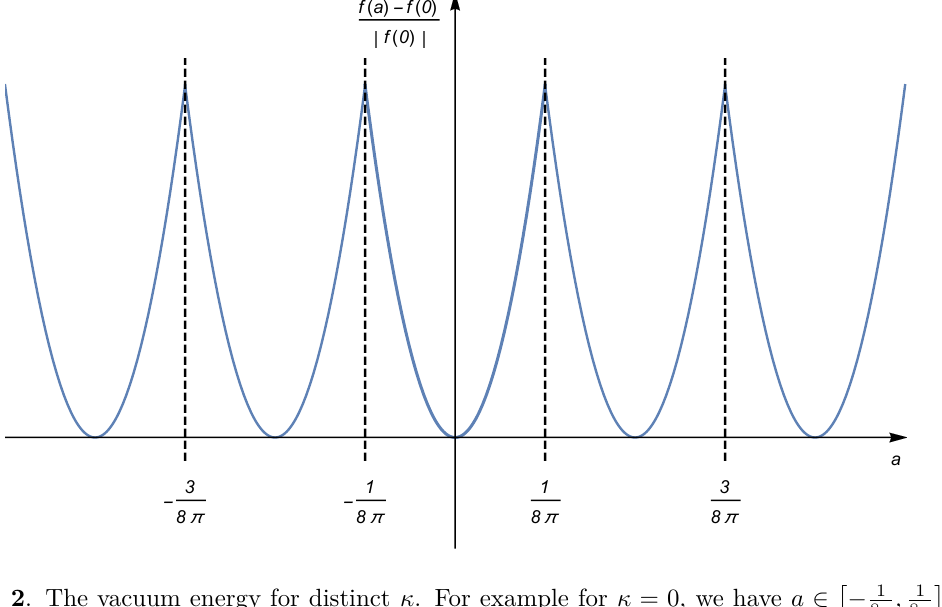
(cid:2) 1 (cid:3) , 3 ; for κ = − 1 8 π 8 π